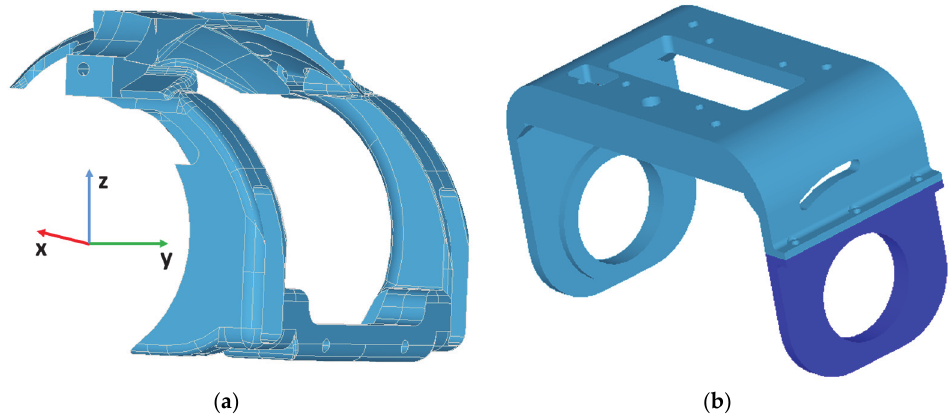
Figure 4. ( a ) Rear hooking bracket; ( b ) payload support base.